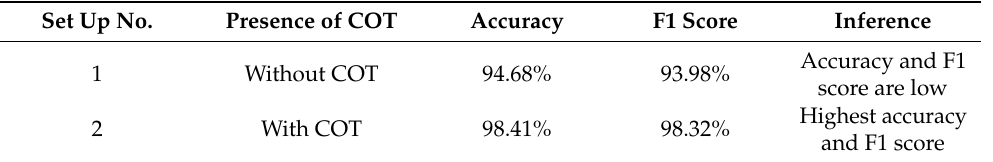
Table 13. Results of ablation study 4, models without channel optimization. Set Up